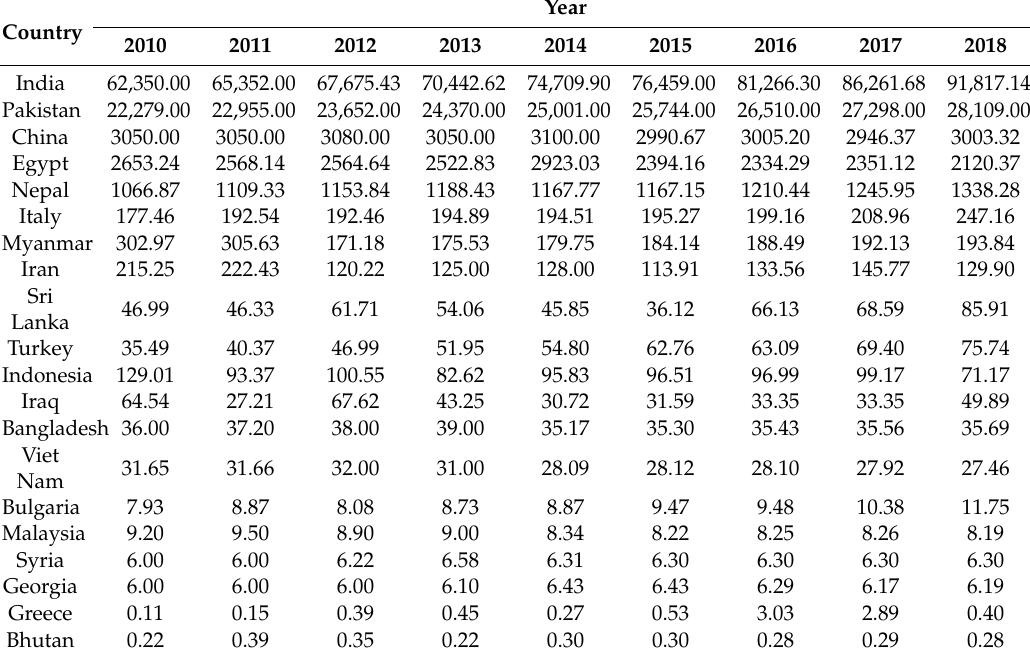
Table 1. Production statistics of whole fresh bu ff alo milk (tones) from the top twenty countries over the period of